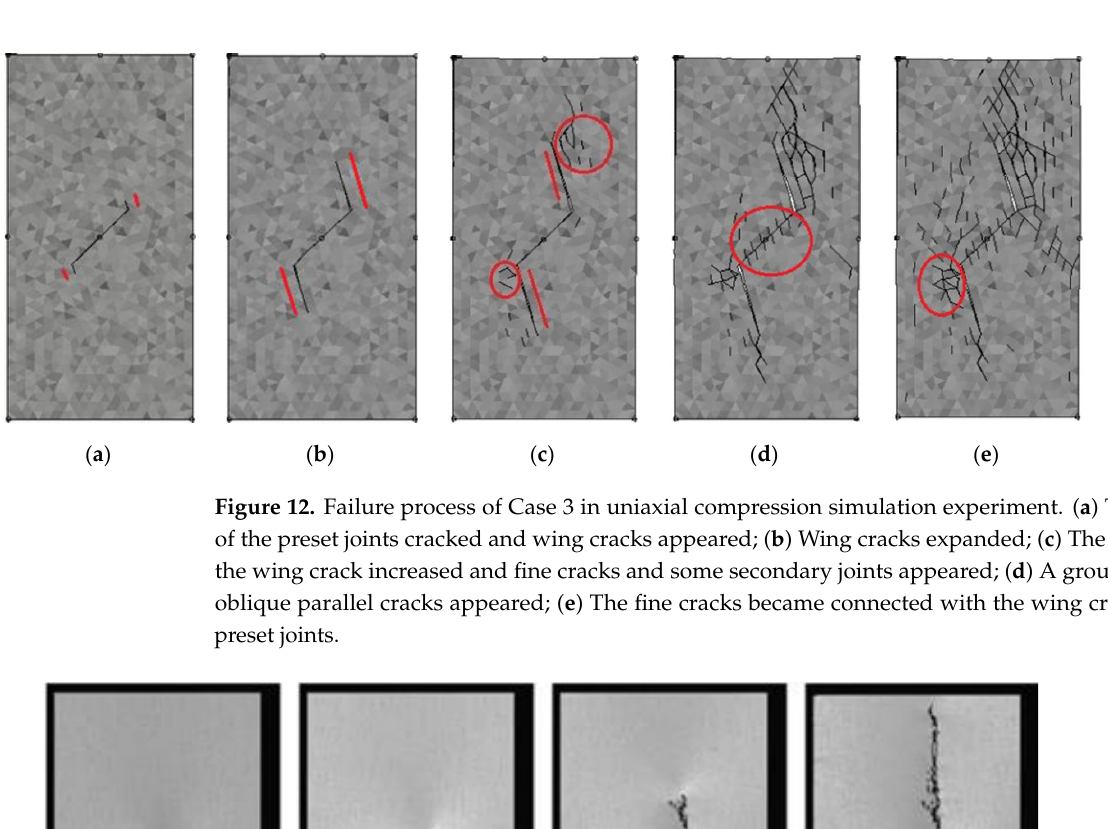
Figure 11. Failure process of Case 2 in uniaxial compression simulation experiment. ( a ) The ends of the preset joints cracked and wing cracks appeared; ( b ) Wing cracks expanded; ( c ) The width of the wing crack increased and fine cracks and some secondary joints appeared; ( d ) A group of new oblique parallel cracks appeared; ( e ) The fine cracks became connected with the wing cracks and preset joints .